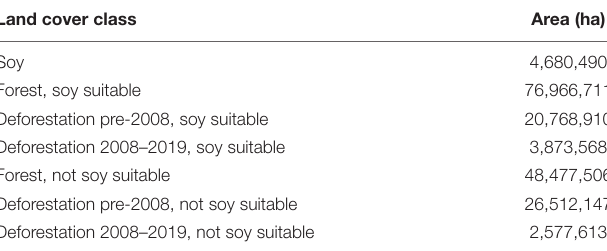
TABLE 2 | Amazon land cover classes outside of protected areas.